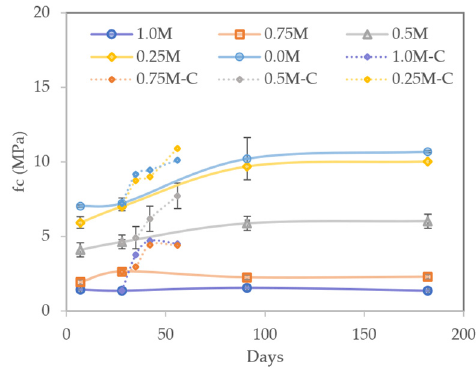
Figure 11. Flexural strength of uncarbonated and carbonated mortars with CAA design.